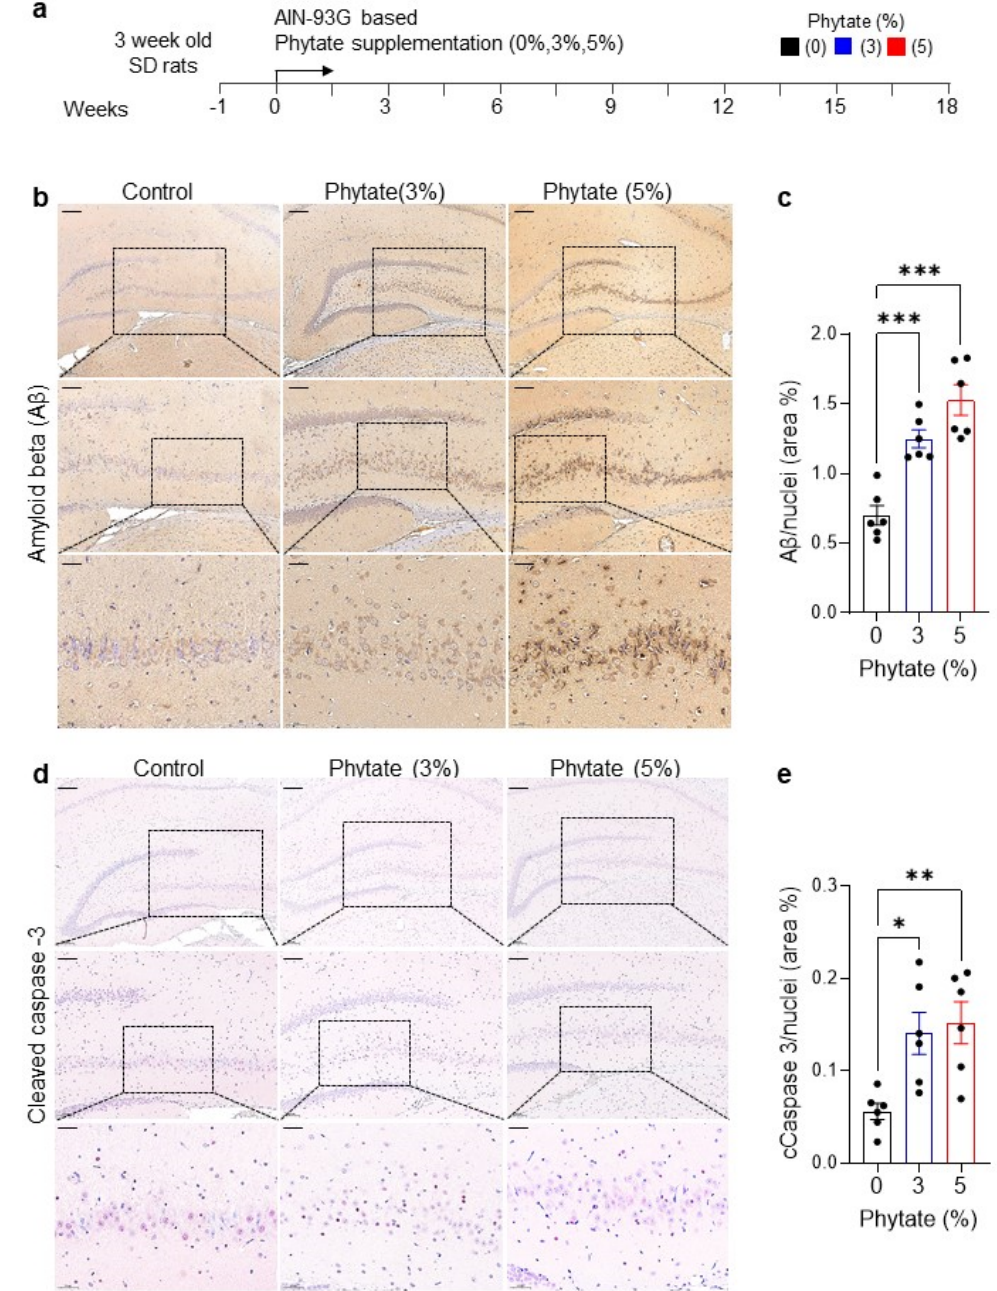
Figure 1. Rats fed a high-phytate, low-Ca 2+ diet show elevated A β accumulation and apoptotic neuronal cell death in the hippocampus: ( a ) Experimental design. After a 1-week period of adaptation to the control AIN93G diet, 4-week-old female Sprague Dawley rats were fed AIN-93G diets with 0% (control), 3%, or 5% phytate supplementation for 18 weeks. ( b ) Representative immunohistochemistry images of A β staining in the brain sections in rats fed 0% (control), 3%, or 5% phytate diets after 18 weeks. Extracellular A β staining showed a distinctive distribution pattern of A β in the hippocampal CA3 and DG regions. Scale bars, 200 µm (low magnification), 100 µm (high magnification), and 50 µm (highest magnifi- cation). ( c ) A β positive cells in the hippocampal CA3 and DG regions were quantified in five to eight low-power fields (mean ± SEM, n = 5–10). ( d ) Representative immunohistochemistry images of cleaved caspase-3 staining in the brain sec- tions in rats fed 0% (control), 3%, or 5% phytate diets after 18 weeks. Scale bars, 200 µm (low magnification), 100 µm (high magnification), and 50 µm (highest magnification). ( e ) Cleaved caspase-3 cells in the hippocampal CA3 and DG regions were quantified within five to eight low-power fields (mean ± SEM, n = 5–10). One-way ANOVA was used for all compar- isons with Dunnett’s multiple comparison test. All data are presented as mean ± SEM for each group ( n = 3–4 lpf/rat). * p < 0.05, ** p < 0.01, *** p < 0.001 compared with controls.